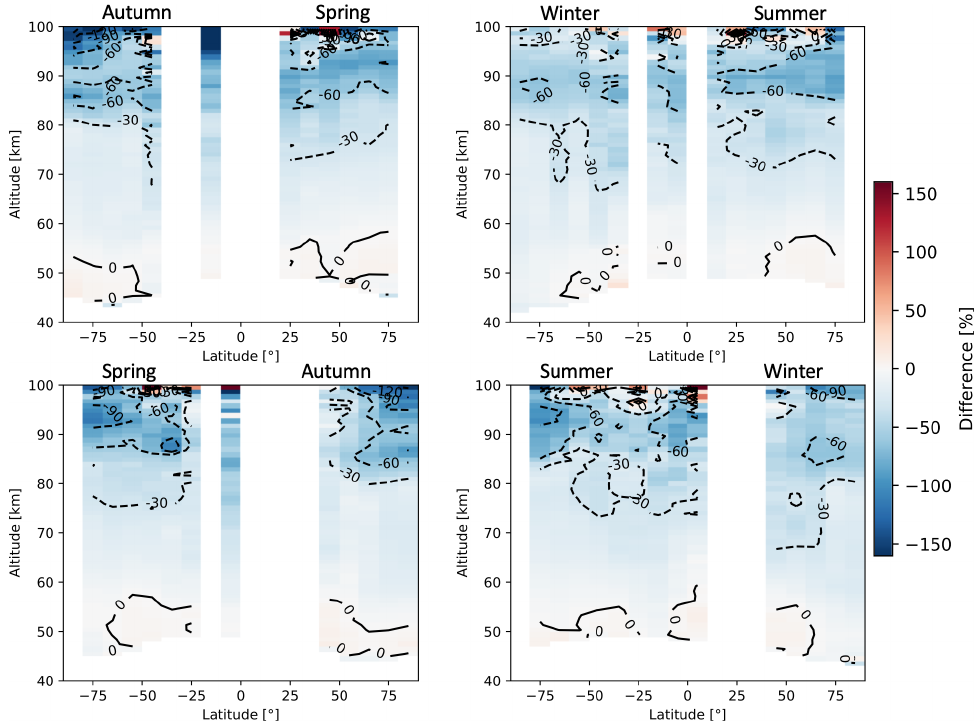
Figure A17. Seasonal zonal means of H 2 O FM19 SMR–ACE relative differences averaged over the time period between February 2004 and April 2019. The seasons are intended as astronomical seasons, i.e. each starting at the respective solstice or equinox.